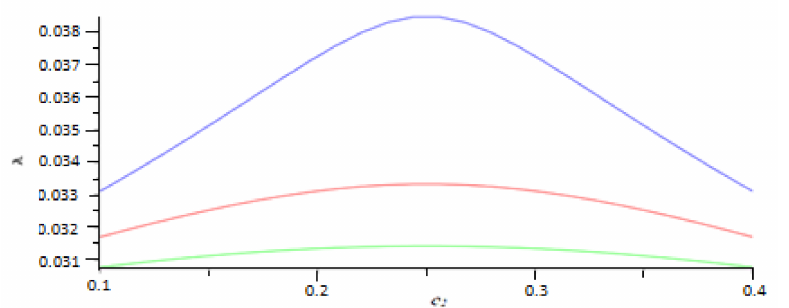
Figure 9. The change in the width of the first bandwidth when crushing the components of a monodis- perse crystal with a constant concentration of 50%. The values of the main parameters are described in the table of parametric crushing of the elements of the unit cell. Here: N1—the constant sizes of the two connected parts of the crushing 0.1 and 0.4, red; N2 is 0.2–0.3, blue; N3 is 0.05–0.45, green.